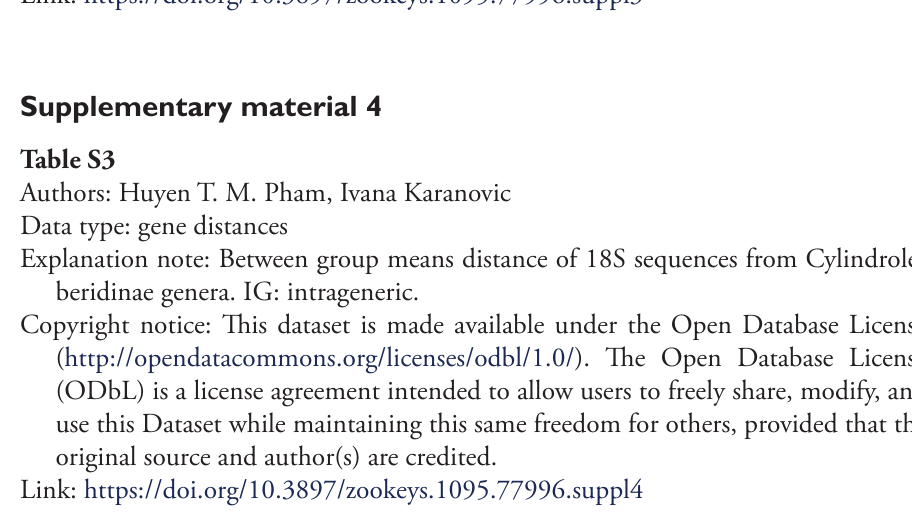
Authors: Huyen T. M. Pham, Ivana Karanovic Data type: gene distances